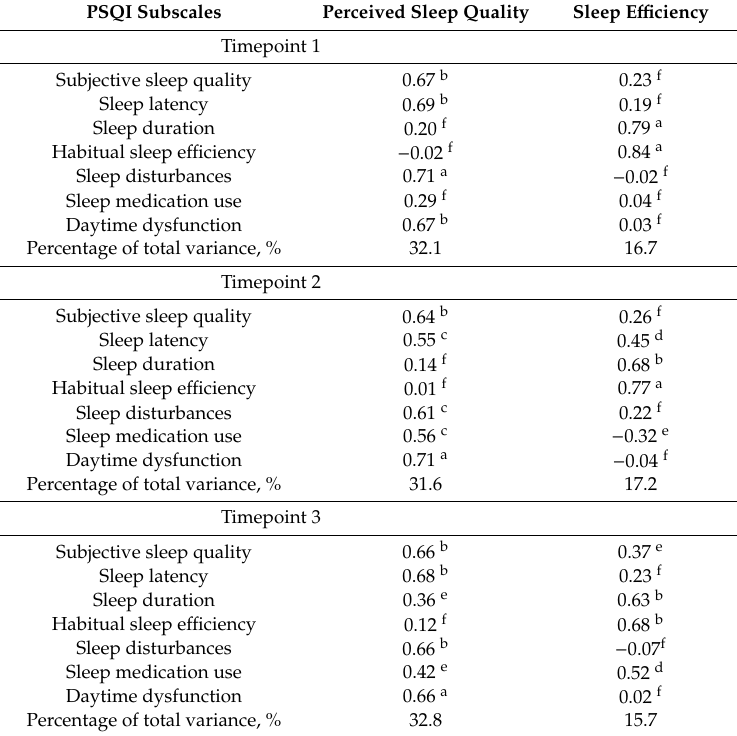
Table 3. Factor Matrix for the two-factor solutions at each